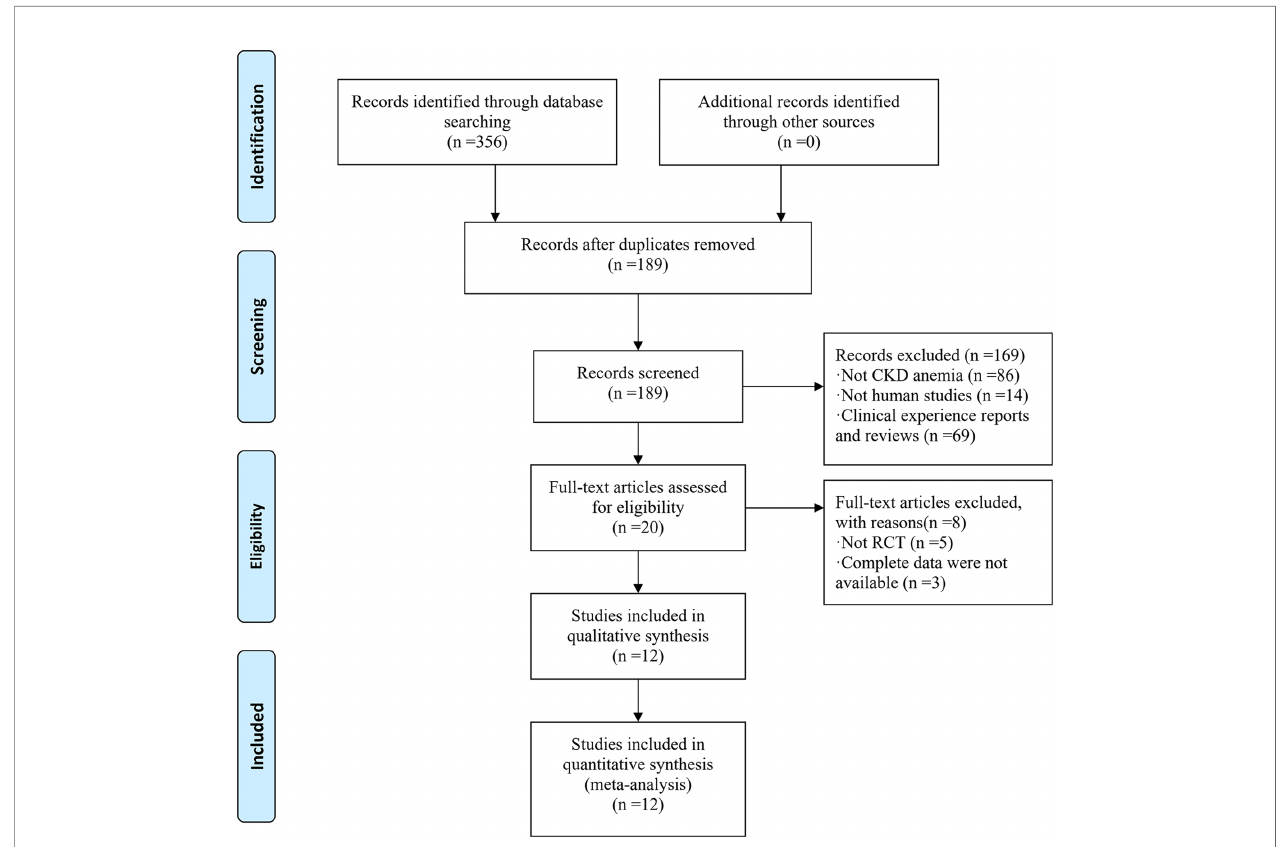
FIGURE 1 | Flow chart of study selection